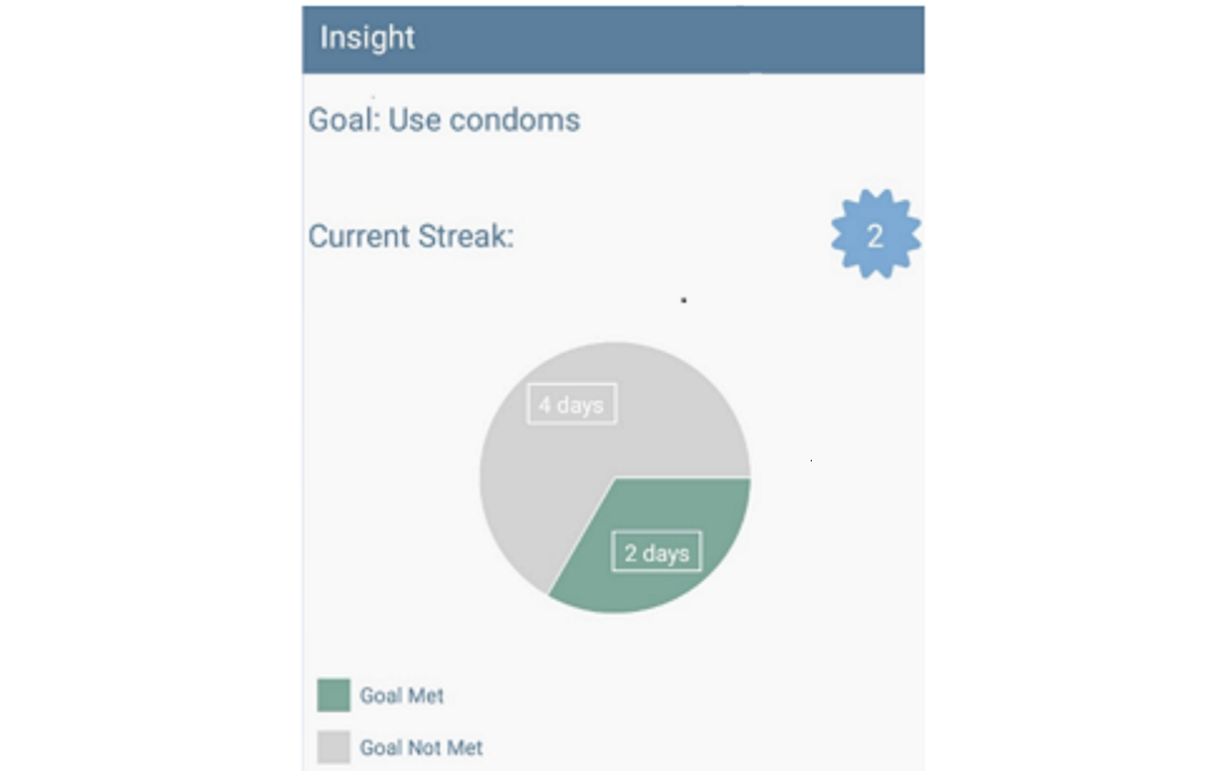
Figure 3. Example behavioral